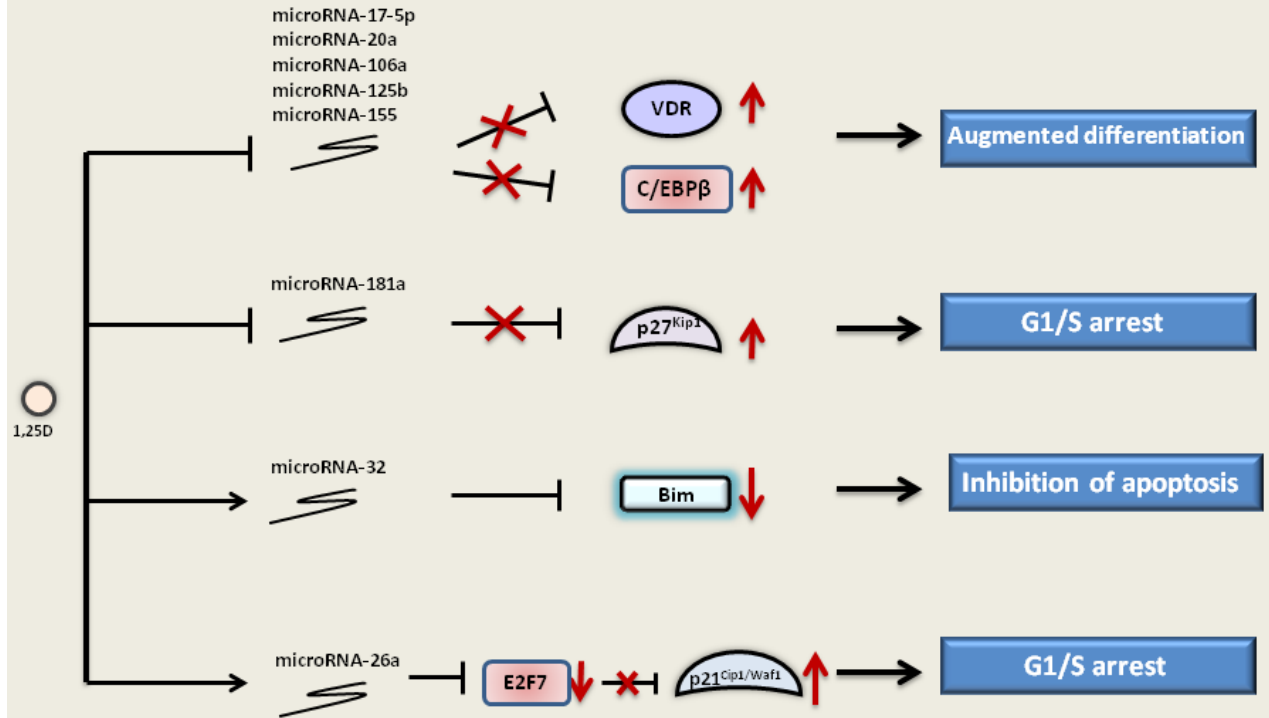
Figure 4. Regulation of microRNA expression by 1,25D in AML